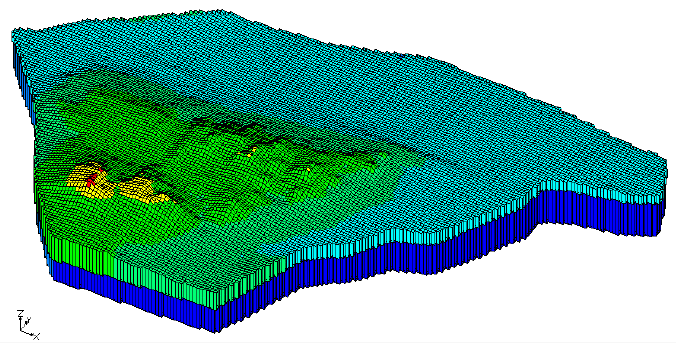
Figure 2. Three-dimensional structure of the hydrogeological model.